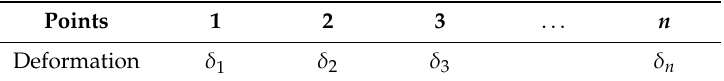
Table 2. Cross-section data structure.